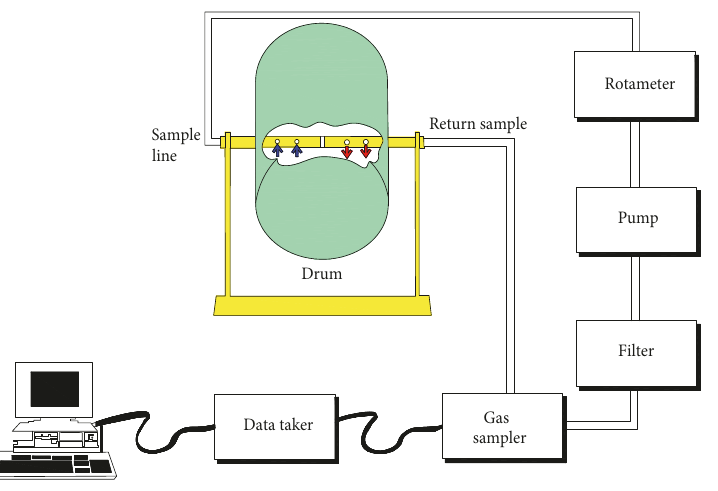
Figure 1: Drum tumbler system.